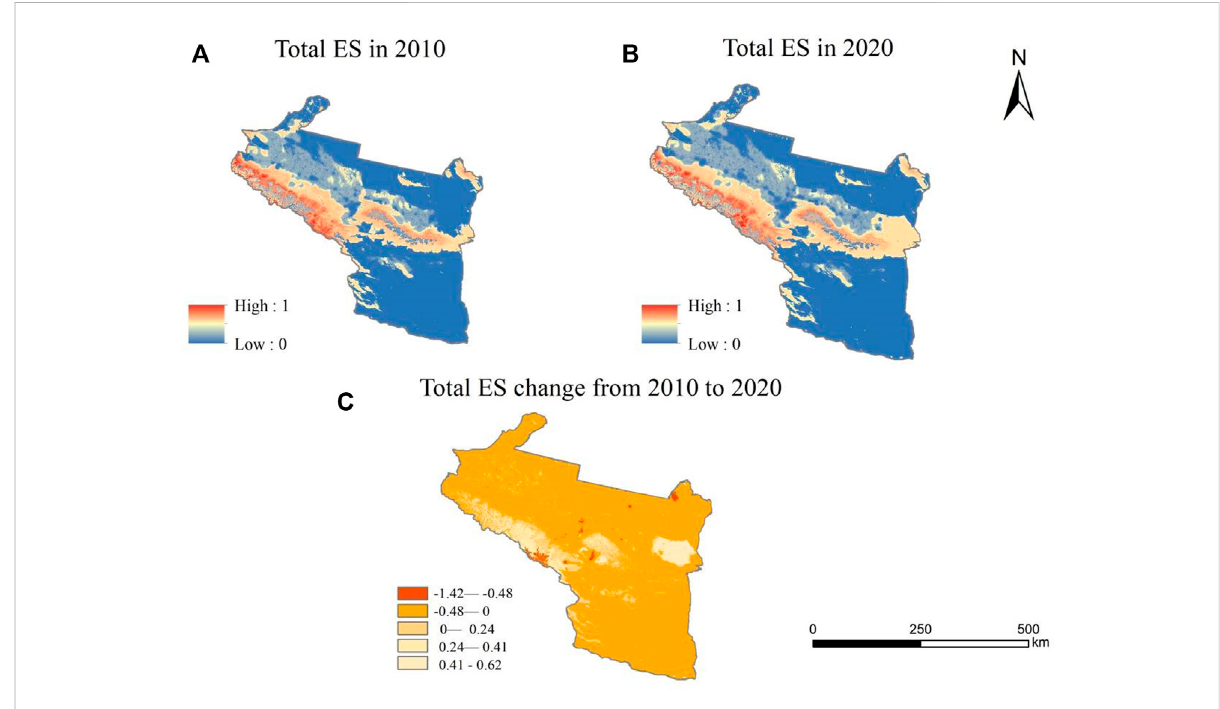
FIGURE 5 Ecosystem services and changes in UANSTM from 2010 to 2020.